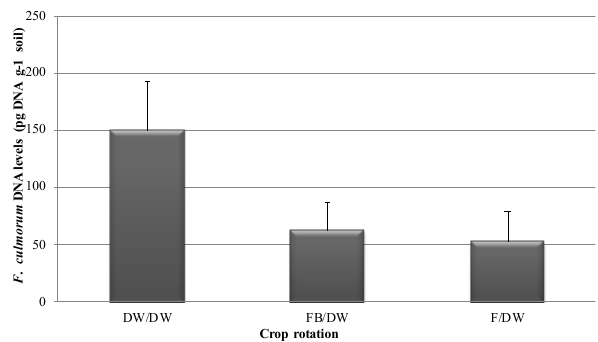
Figure 2. Amounts of Fusarium culmorum DNA in soil (pg DNA -1 g of soil) 1 year after different crop rotations from the experi- mental field trial at Bou Salem, Tunisia. Error bars are 2 × stand- ard deviations. DW: durum wheat, FB = faba bean, F = fenu- greek.